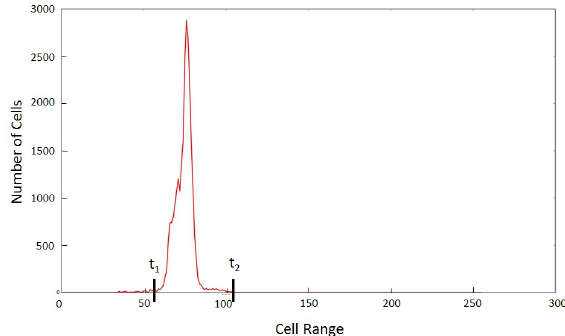
Figure 3: 3D LiDAR points contained within convex hulls be- longing to candidate road roughness